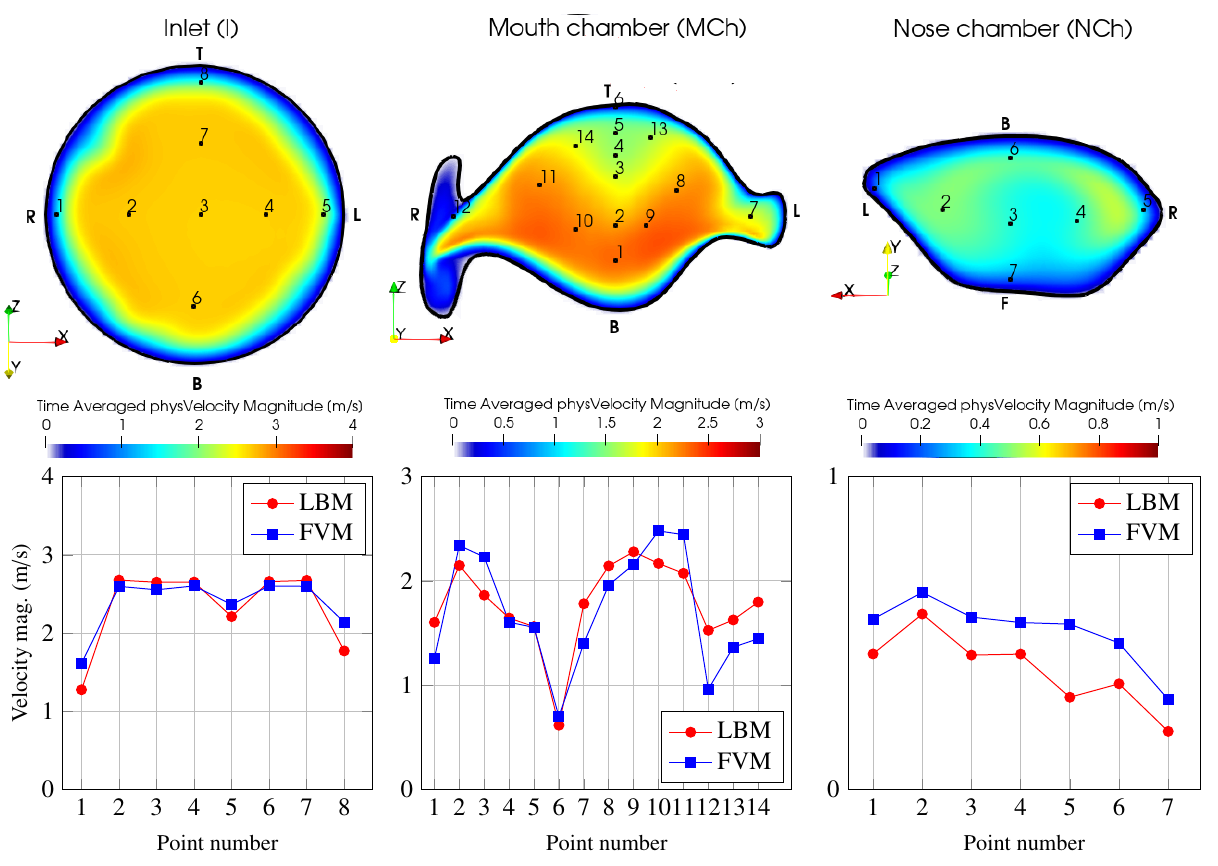
Fig. 4. Comparison of velocity fields at the investigated positions in the inlet and in the mouth and nose